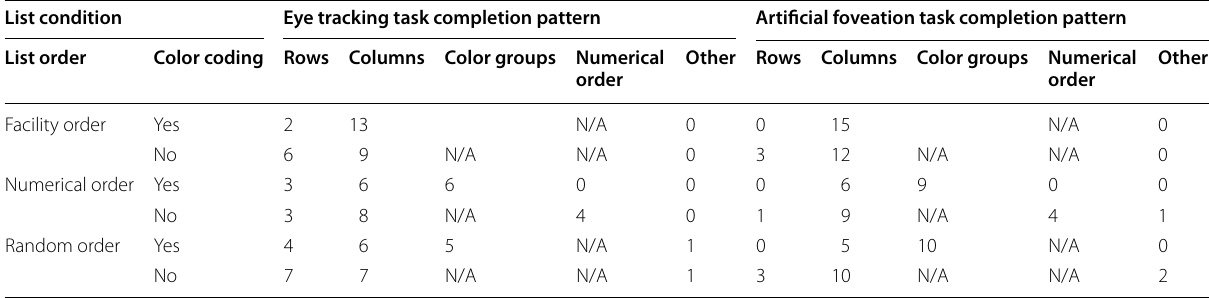
Table 2 The number of participants using each task completion strategy for each list presentation condition in the eye tracking and artificial foveation